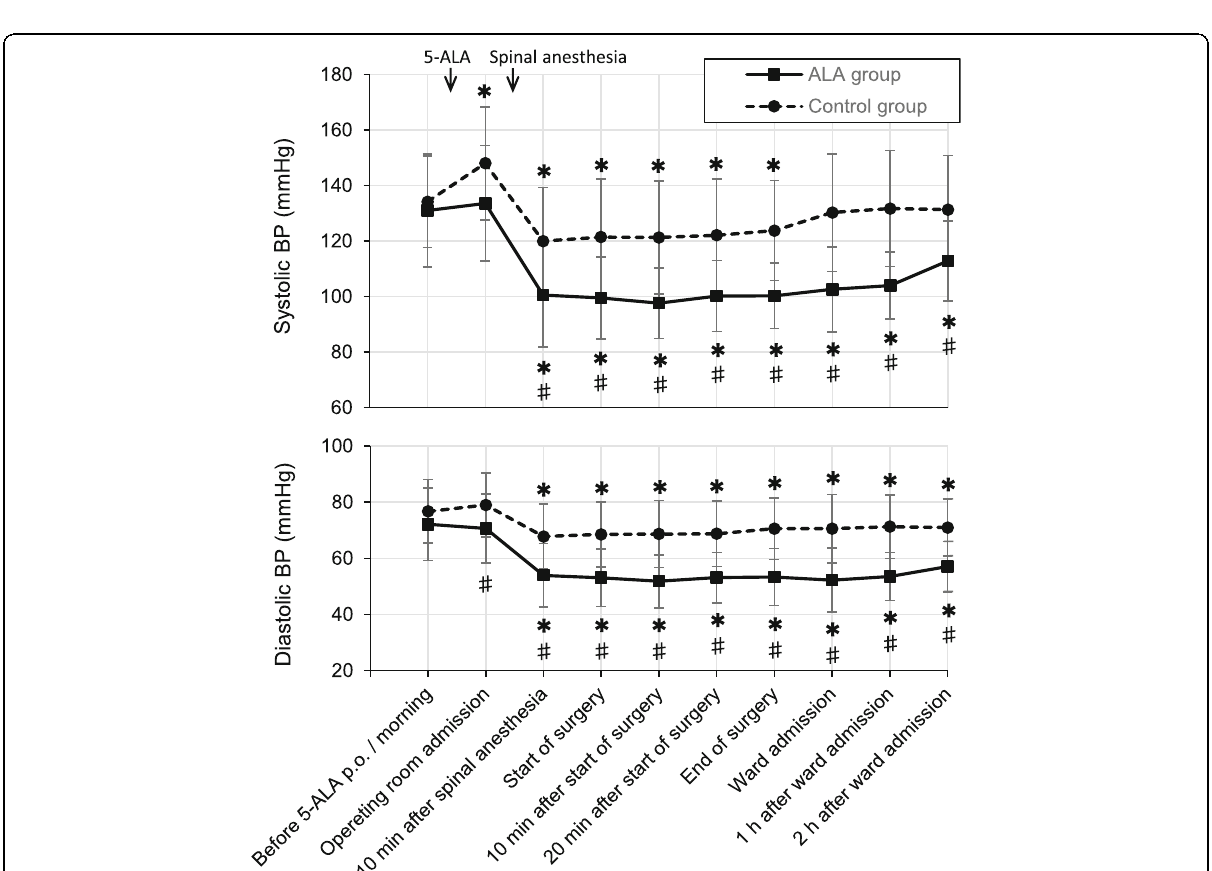
Fig. 1 Time courses of systolic blood pressure and diastolic blood pressure. Values are presented as mean ± standard deviation. * P < 0.05, post-operating room admission versus before 5-ALA p.o./morning. # P < 0.05, the ALA group versus the control group. ALA aminolevulinic acid, BP blood pressure, p.o. per os